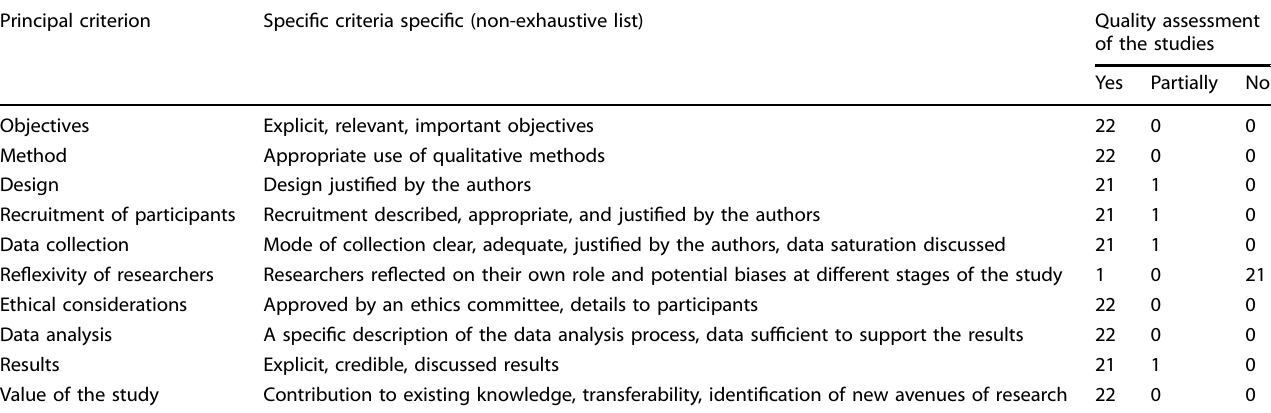
Table 2. Summary of quality